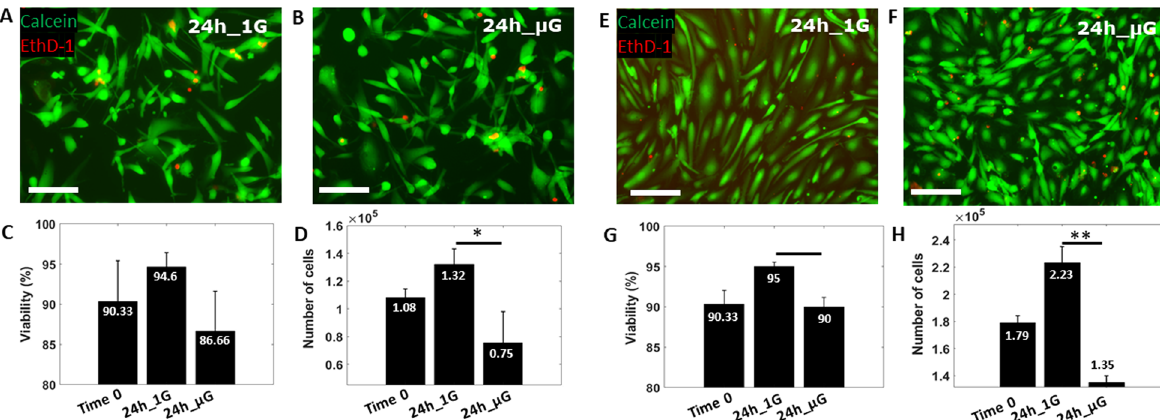
Fig. 3 Viability and proliferation assay. Live cell images of Glioblastoma A-172 and HUVEC cells, showing Calcein AM in green and ethidium homodimer-1 (EthD-1) in red after 24 h of gravity (1 G) ( A, C ) and μ G ( B, D ) conditions respectively. Cell viability ( E, G ) and proliferation evaluation ( F, H ) for A-172 and HUVEC cells respectively, at different experimental condition. Images have been acquired with ×40 magni fi cation lens thus they refer to a small section of the entire chamber. Scale bars, 100 µm. Data are shown as the mean ± SEM ( n = 3). Asterisks are reported for cases with statistical signi fi cance: * GBM number of cells: 24 h 1 G vs 24 h μ G, p = 0.03, * HUVEC viability: 24 h 1 G vs 24 h μ G, p = 0.017 ** HUVEC number of cells: 24 h 1 G vs 24 h μ G, p = 0.0025. The statistical analysis of the data was performed using one-way analysis of variance (ANOVA) with Turkey ’ s test for multiple